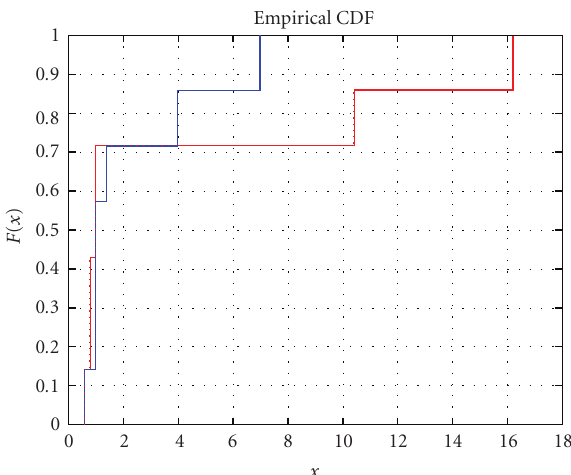
Figure 9: Kolmogorov-Smirnov test for graph radius. The plot (although the sample size is small) shows the di ff erence between a cell graph with randomly scattered nodes and one with segmented